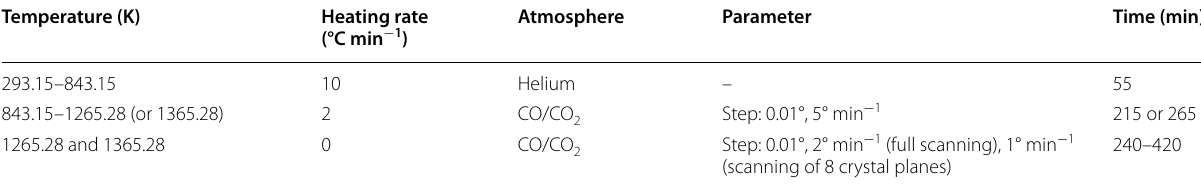
Table 1 Experimental conditions of the XRD measurements Temperature